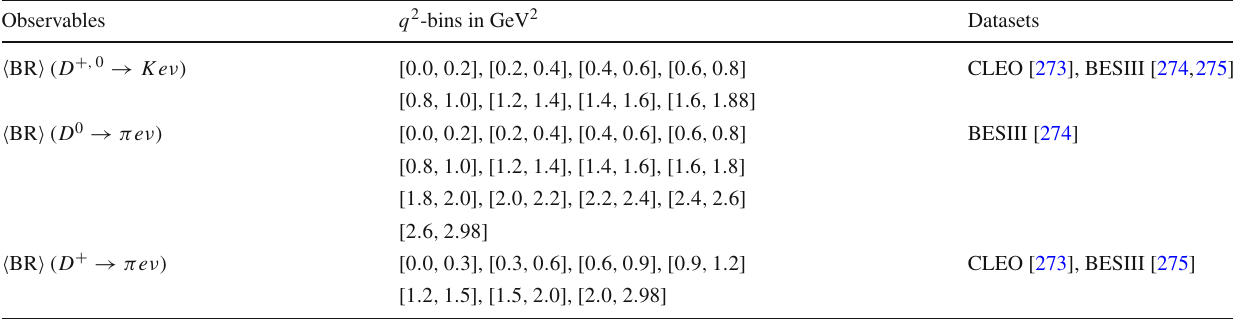
Table 11 Datasets on binned branching fractions in charged current charm decays Observables q 2 -bins in GeV 2